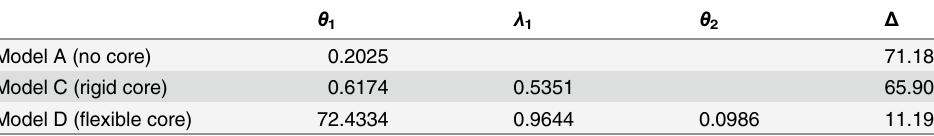
Table 2. Model fit parameters. Models described by Haegeman and Weitz [10]. Model A: neutral model with all genes exchanged with environment with parameter θ 1 . Model C: Genome has a fraction ( λ 1 ) of the genome that is rigid (the core), and the rest exchanges genes with the environment with parameter θ 1 . Model D: Similar to model C except the core exchanges genes with the environment with parameter θ 2 . The distance from the model fit to the data for B . pseudomallei is given by Δ , with smaller numbers signifying better